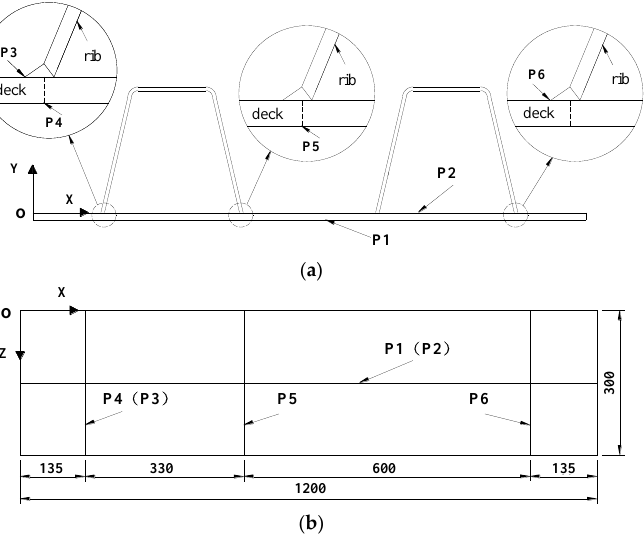
Figure 3. Diagram of the measurement paths: ( a ) cross section diagram; ( b ) plan diagram (units: mm).